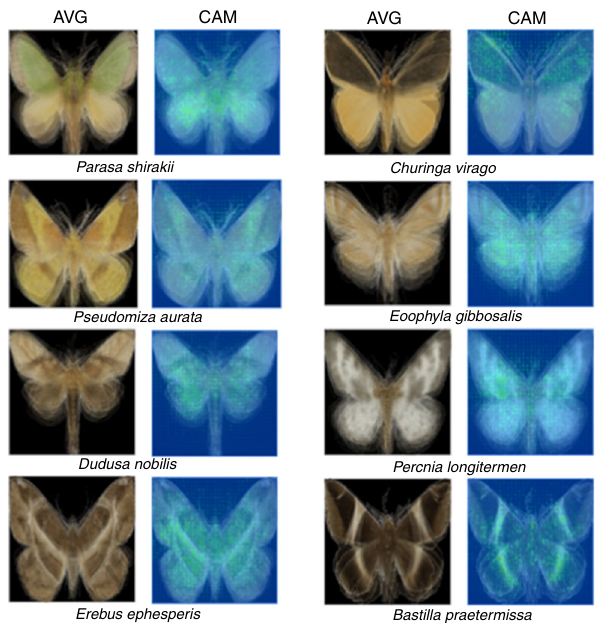
Fig. 2 Class activation mapping generated localized discriminative visual features of arbitrarily selected images of eight species of moths. CAM represents class activation mapping, which is a method of localizing the discriminative image regions 59 . AVG shows the mean RGB of each pixel from images of all individuals of a